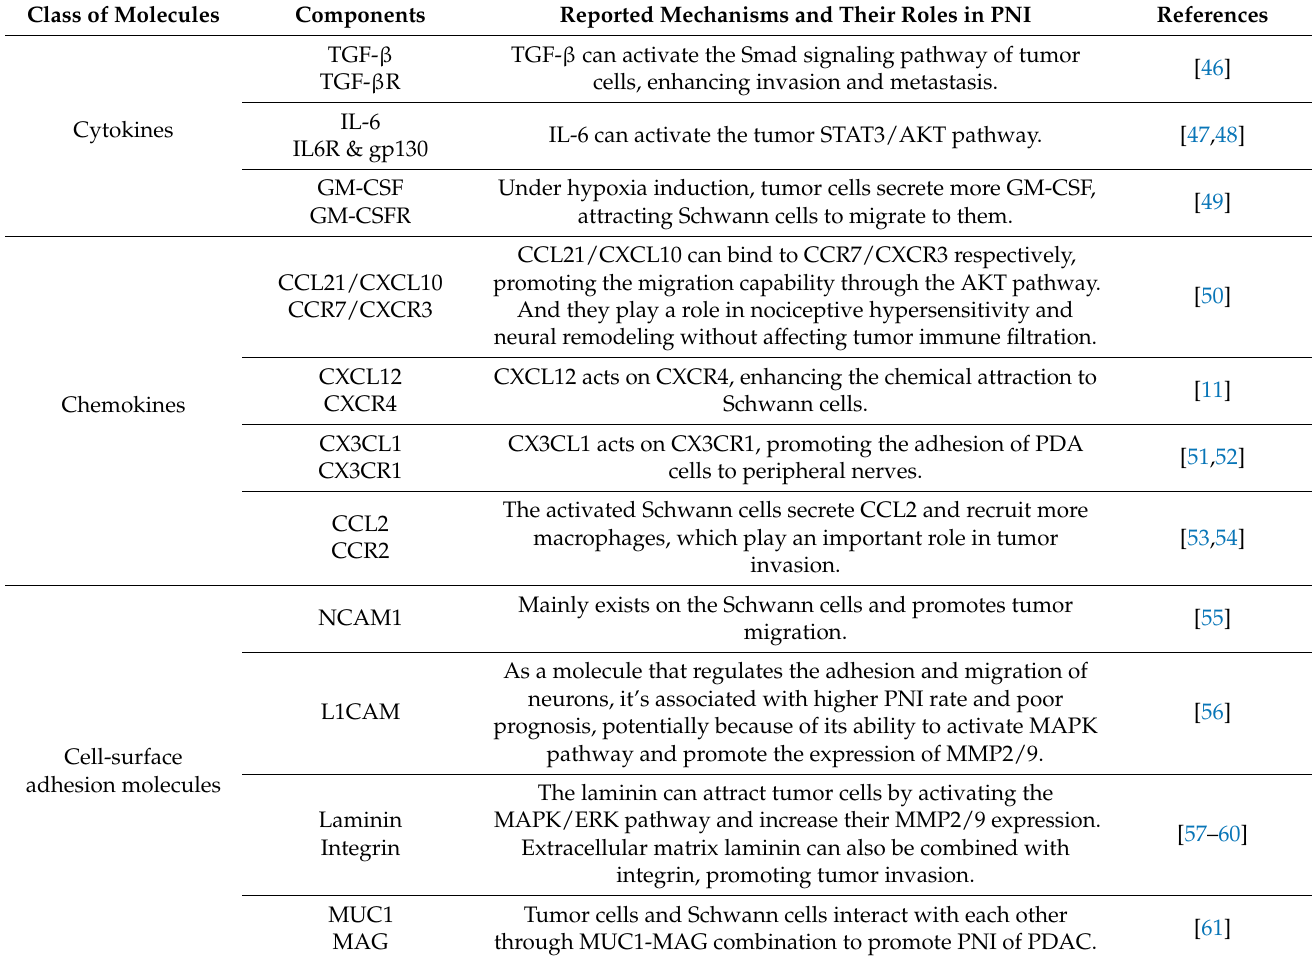
Table 3. Cytokines, chemokines, and cell-surface adhesion molecules involved in PNI. Class of